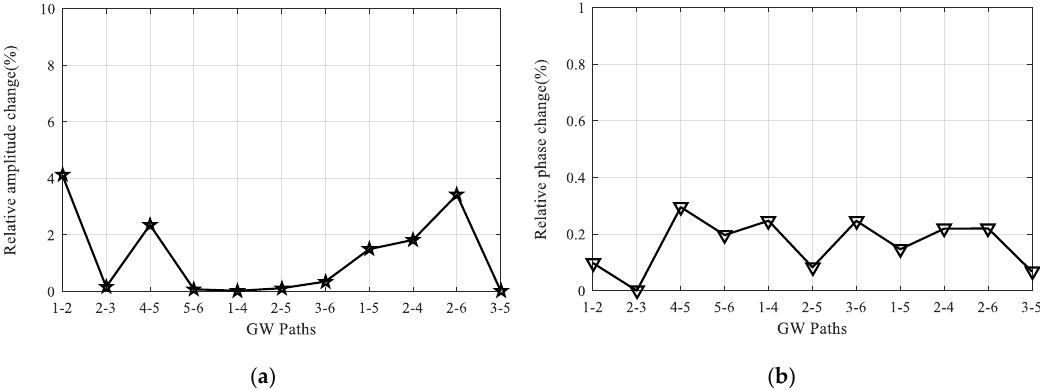
Figure 19. Relative signal change of all the paths after overload tests. ( a ) Relative amplitude change. ( b ) Relative phase change. Table 3. Overload test